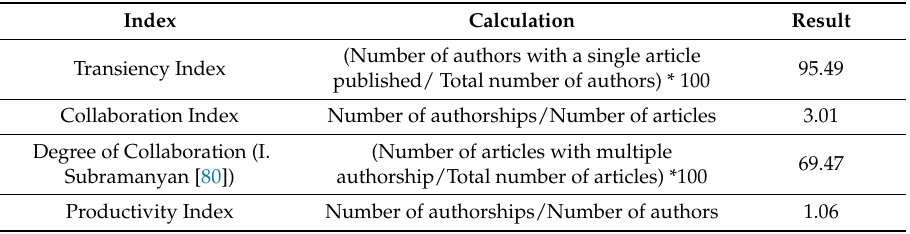
Table 6. Some indicators associated with authorship.